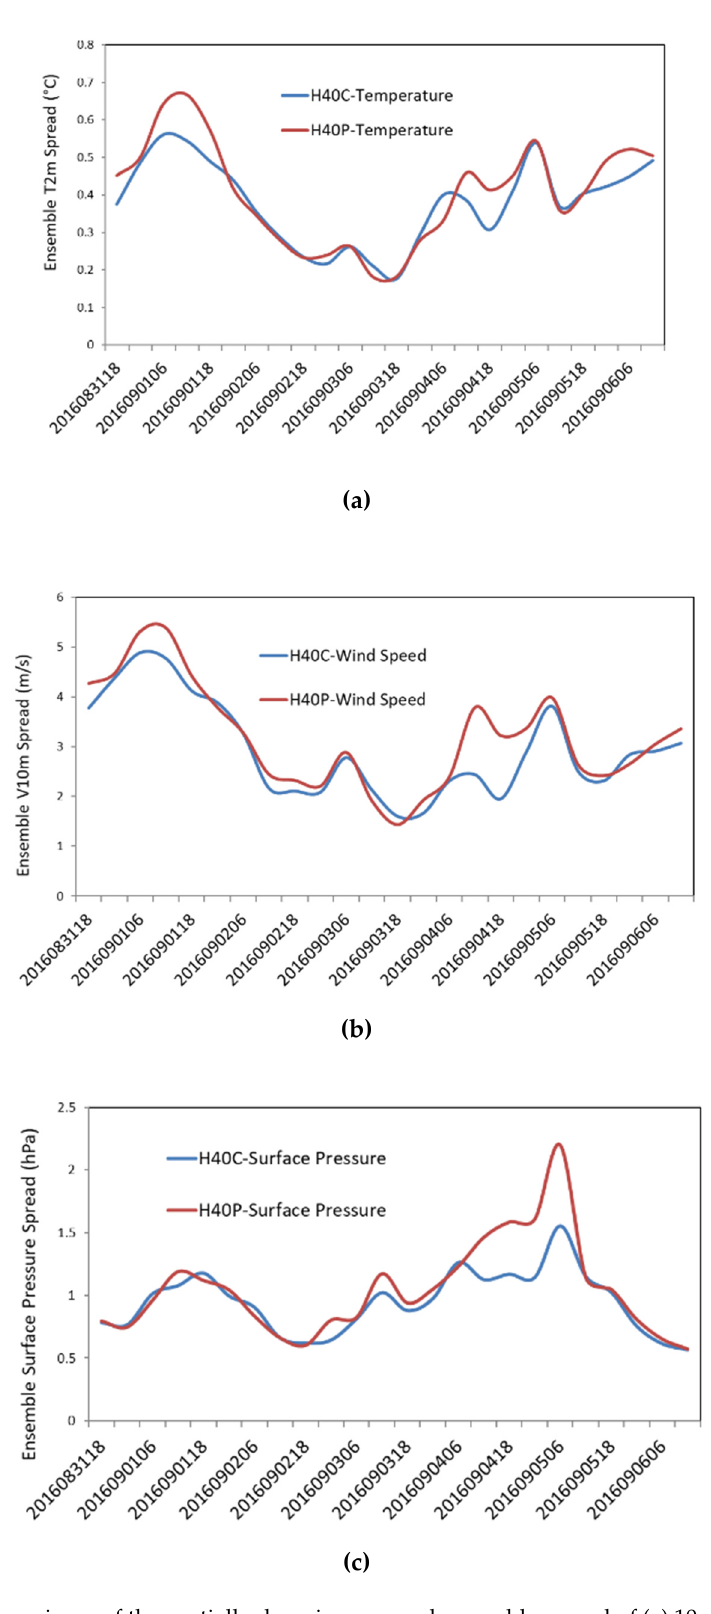
Figure 2. Comparisons of the spatially domain-averaged ensemble spread of ( a ) 10 m wind, ( b ) 2 m temperature, and ( c ) the mean sea-level pressure between the H40C (blue line) and H40P (red line), for Hurricane Hermine, 2016.